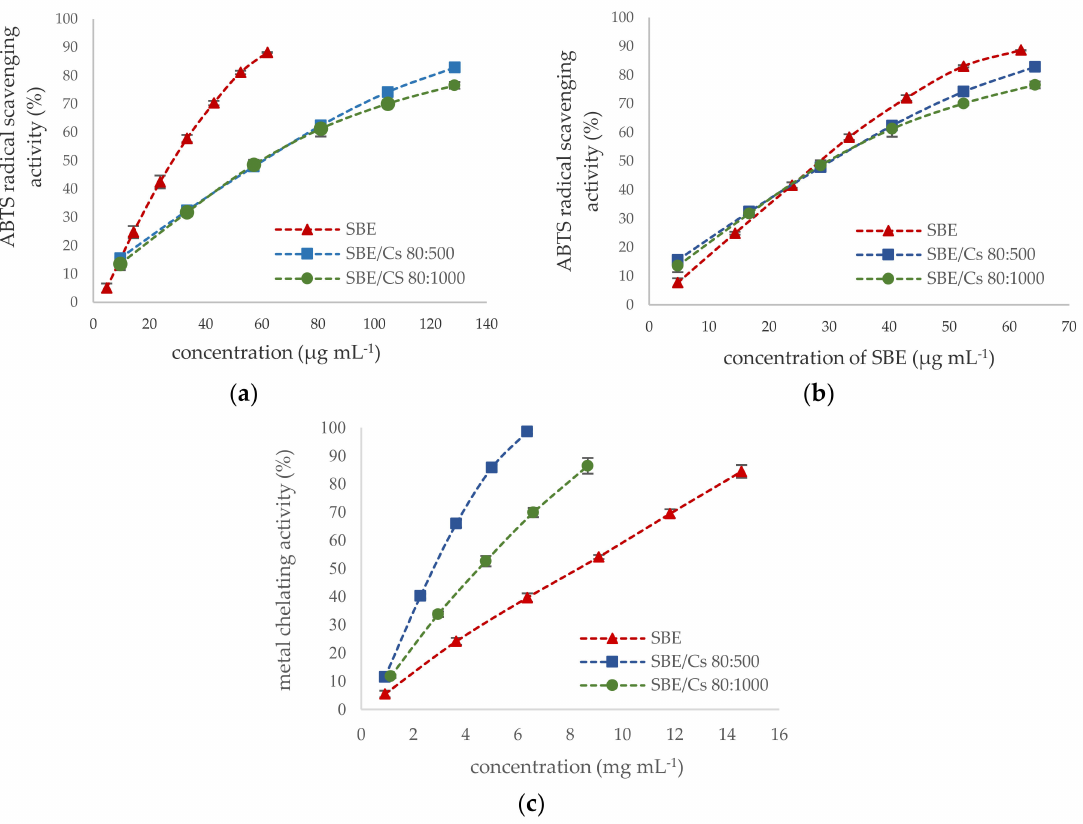
Figure 4. Concentration-dependent antioxidant activity of S. baicalensis extract and binary mixtures. ( a ) ABTS assay calculated per µ g of SBE and binary mixtures (mean ± S.D., n = 6); ( b ) ABTS assay calculated per µ g of SBE in binary mixtures; ( c ) metal-chelating activity (mean ± S.D., n =